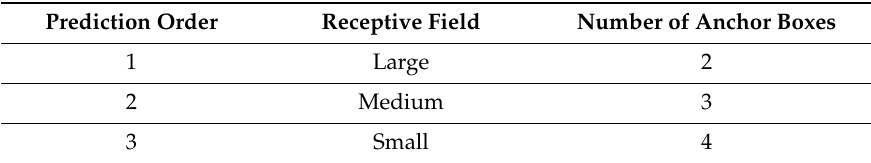
Table 2. The anchor design of the CFF-SDN model. Prediction Order